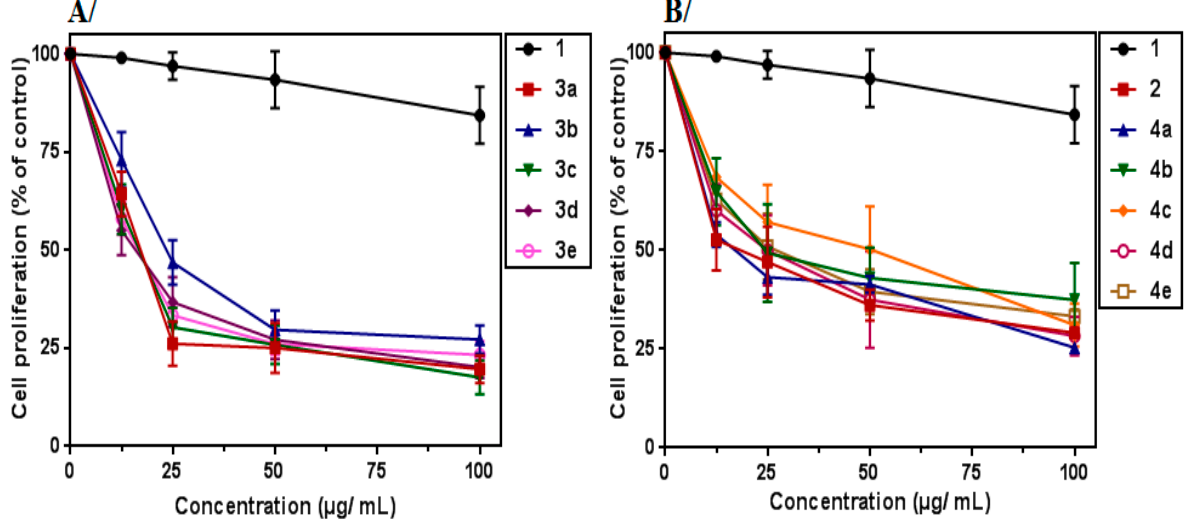
Figure 2. Effect of tyrosol ( 1 ) and its derivatives on K562 cell proliferation: ( A ) K562 cells treated with tyrosol ( 1 ) and the synthesized isoxazoles ( 3a – e ) for 72 h; ( B ) K562 cells treated with tyrosol ( 1 ), tyrosol-alkyne ( 2) and the synthesized triazoles ( 4a – e ) at various concentrations for 72 h. Data represent the mean ± SEM of three independent experiments performed in triplicate. All data were statistically significant ( p < 0.05), except tyrosol ( 1 ) at 12.5, 25 and 50 µ g/mL. Table 3. Anti-proliferative activity of compounds tyrosol-alkyne ( 1 ), cycloadducts ( 2 ), ( 3a – e ) and ( 4a – e ) on the K562 tumor cell